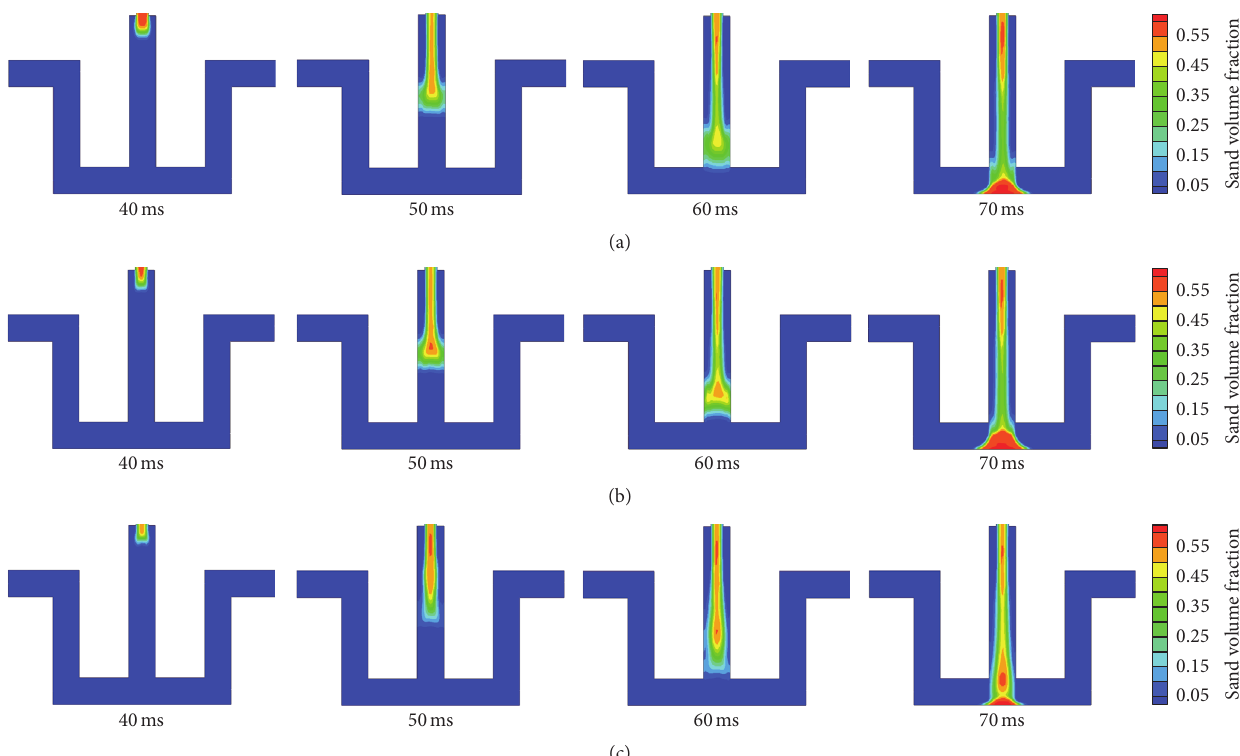
Figure 11: Comparison of simulated maps of sand volume fraction for drag modification coefficient of (a) 𝐶 = 1 , (b) 𝐶 = 0.5 , and (c) 𝐶 = 0.05 .